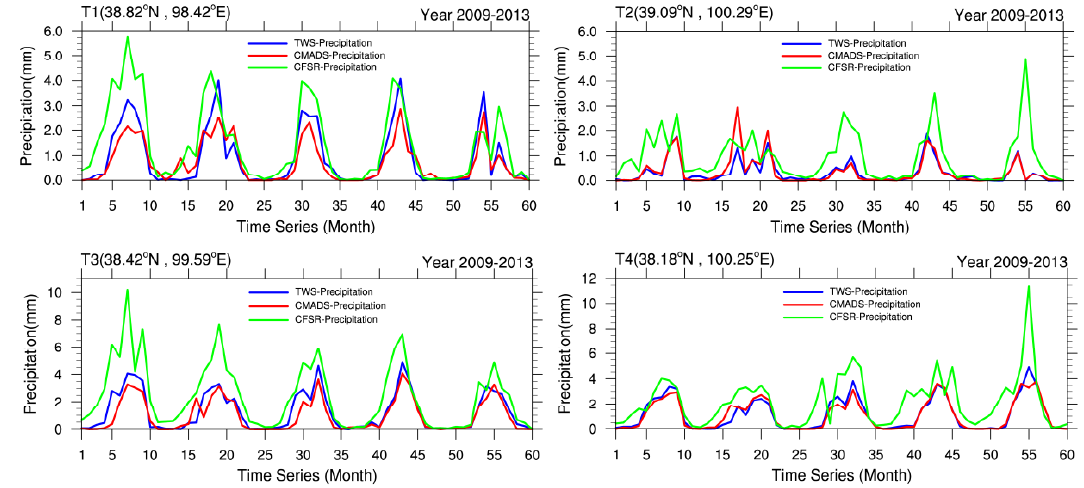
Figure 4. Average monthly precipitation according to TWS (blue), CMADS (red), and CFSR (green) at four sites (T1–T4) from 2009 to 2013.